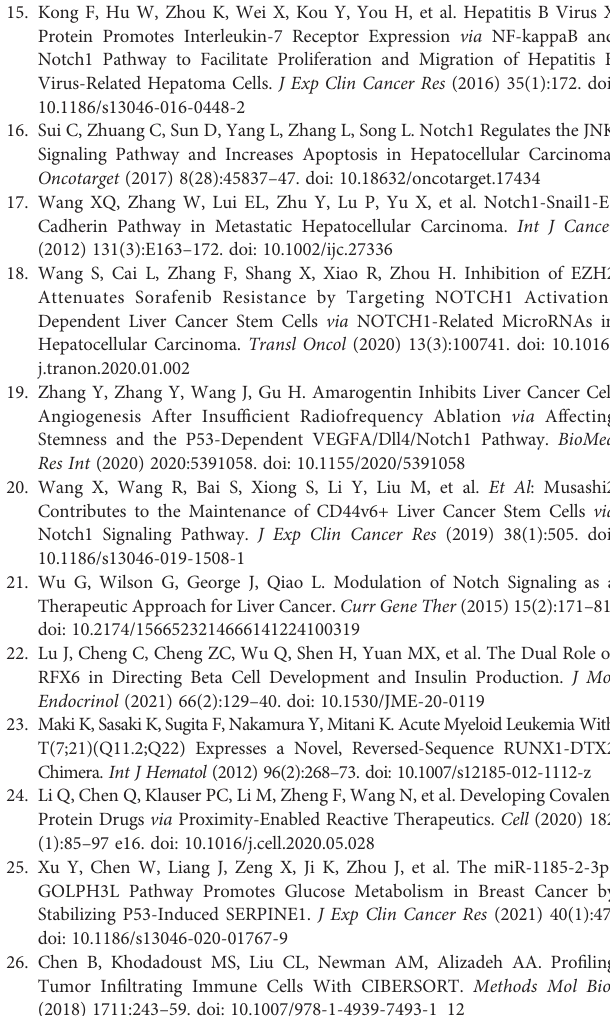
expression could signi fi cantly regulated the invasion of Huh7 cells. Data were represented as mean ± standard deviation (s.d.), n=3, **p <0.01. Supplementary Figure 3 | miR-542-3p overexpression partially reversed the tumorigenesis induced by RFX6 overexpression. (A) mRNA expression changes of immune cell receptor marker genes in HepG2. Data were represented as mean ± standard deviation (s.d.), n=3, * p <0.05, **p <0.01. (B) Migration cell count of liver cancer cells. Data were represented as mean ± standard deviation (s.d.), n=3, *p <0.05, **p <0.01. (C) Invasion cell count by transwell assay of liver cancer cells. Data were represented as mean ± standard deviation (s.d.), n=3, **p <0.01. (D) The protein levels of RFX6 in HepG2 and Huh7 cells. (E) Rfx6 was con fi rmed to interact with DTX2 in HepG2 cells by Co-IP assay. (F) The expression of RFX6 protein (left panel) and mRNA level of DTX2 (right panel) after increasing the expression of miR- 542-3p in HepG2 and Huh7 cells. (G) Colony numbers of HepG2 and Huh7 cells. Data were represented as mean ± standard deviation (s.d.), n=3, **p